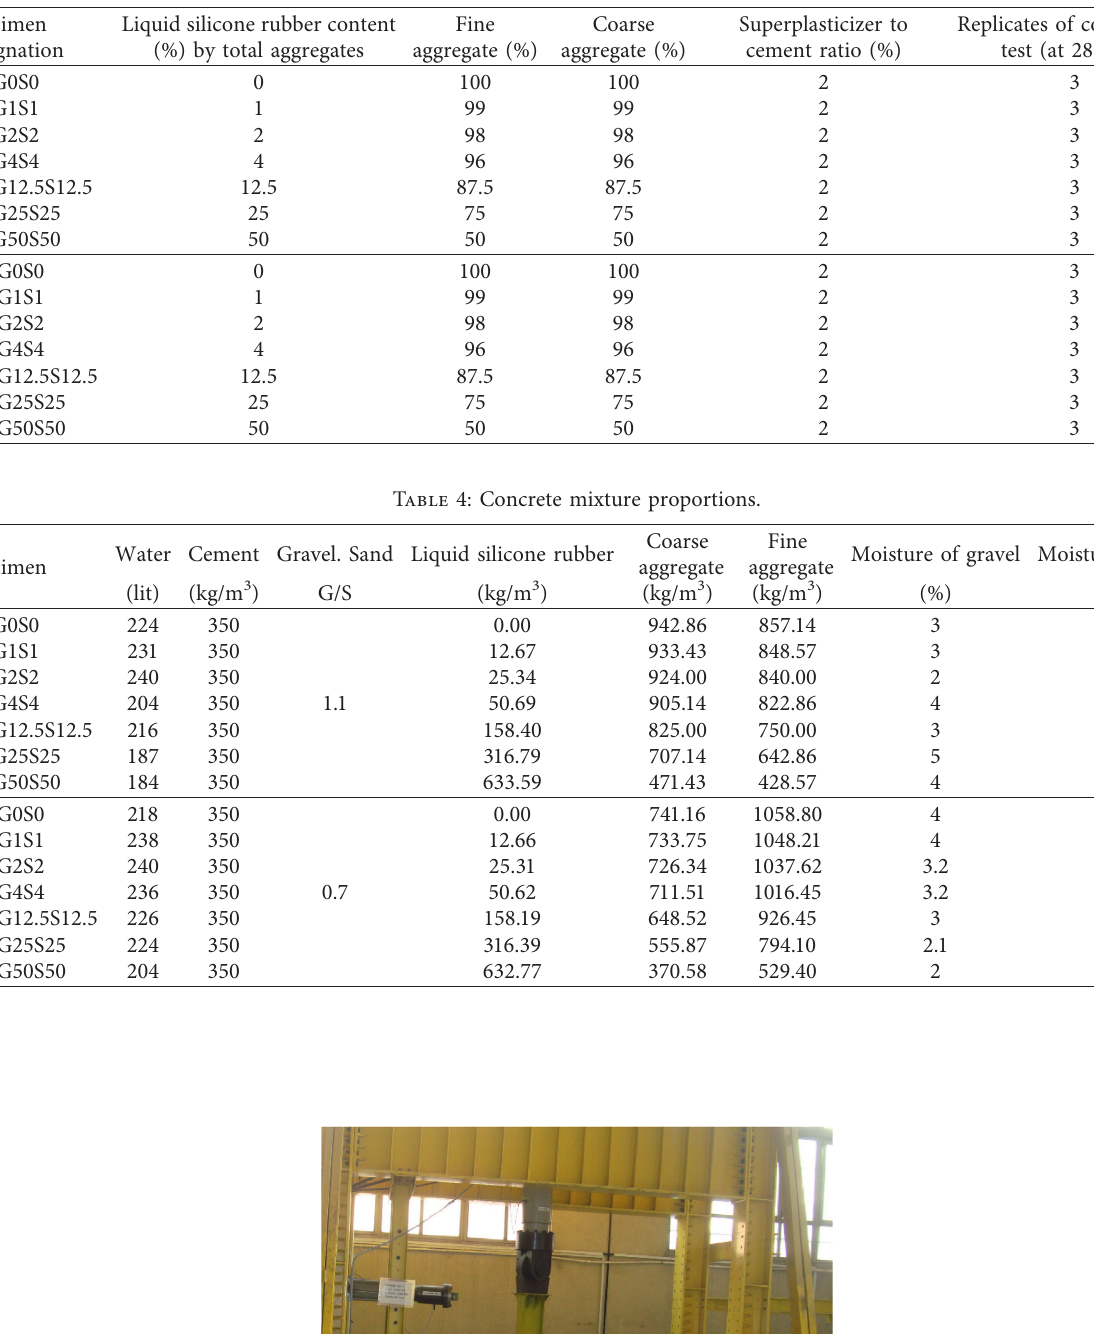
Table 3: Experimental program.